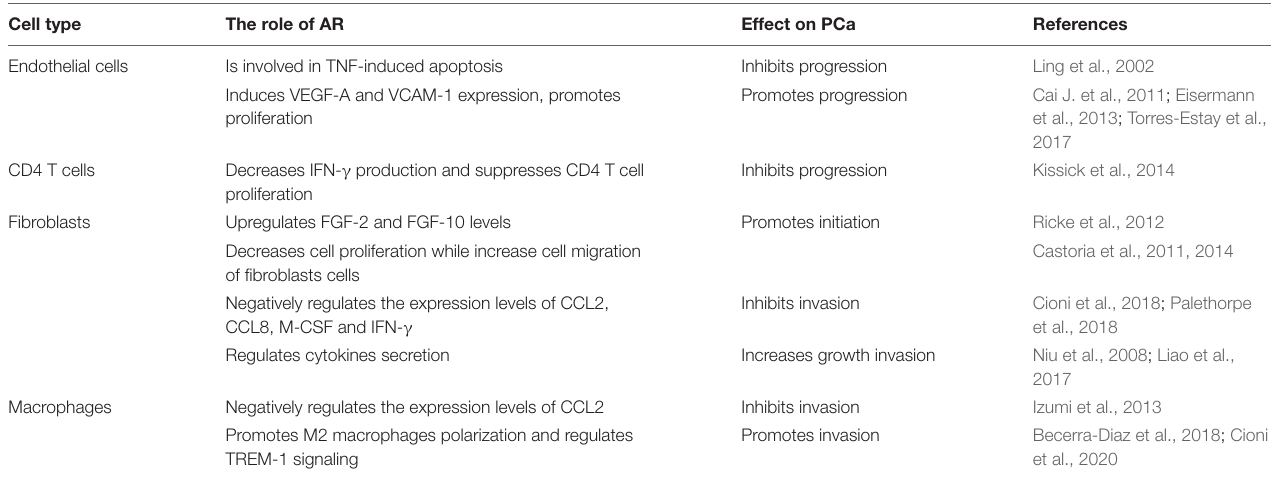
TABLE 2 | The role of AR in PCa stromal